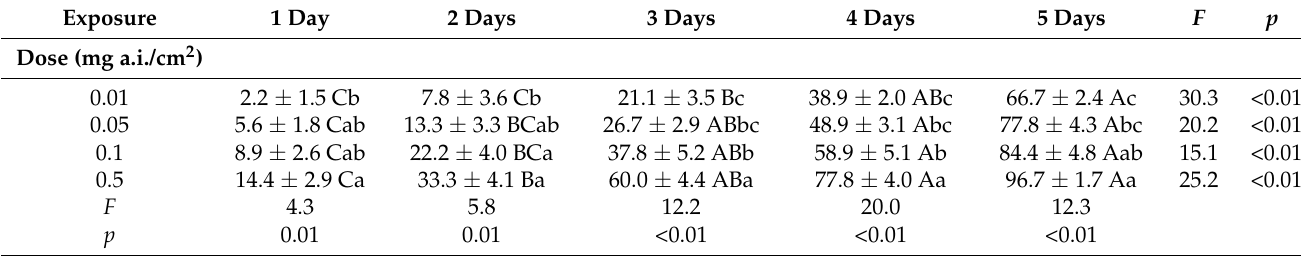
Table 3. Mean immediate mortality (% ± SE) of Tribolium castaneum larvae exposed on concrete treated with chlorantranilip- role at four doses (0.01, 0.05, 0.1, and 0.5 mg a.i./cm 2 ) for 1, 2, 3, 4, and 5 days. Within each row, means followed by the same uppercase letter are not significantly different (in all cases DF = 4, 44, Tukey–Kramer HSD test at p = 0.05). Within each column, means that are followed by the same lower-case letter are not significantly different (in all cases DF = 3, 35, Tukey–Kramer HSD test at p = 0.05). Where no letters exist, no significant differences were recorded.